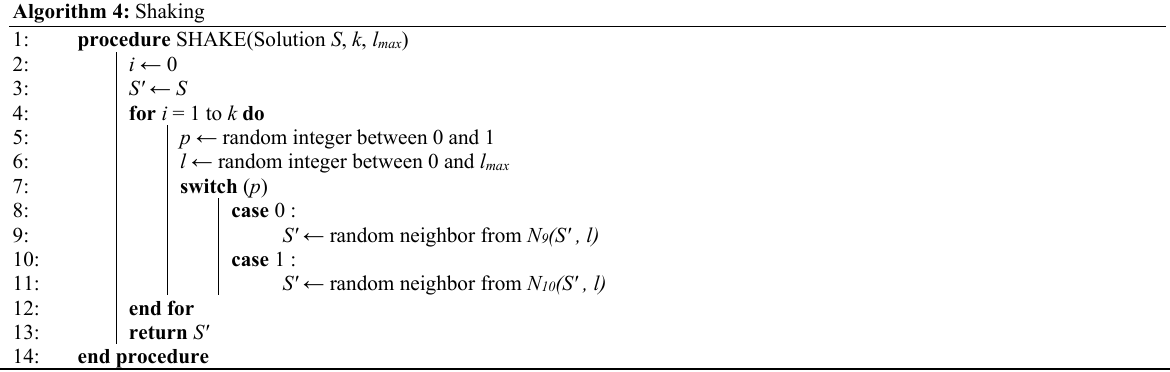
. We then transform the current solution using (cid:3040)(cid:3028)(cid:3051)